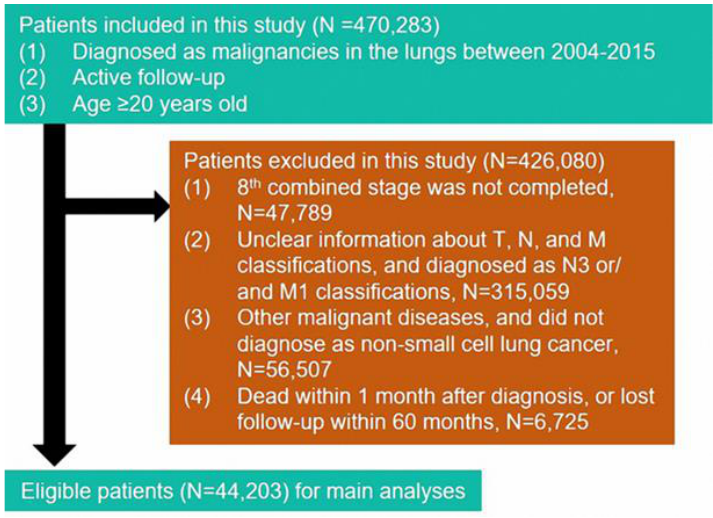
Figure 1. Flow chart of patient screening.